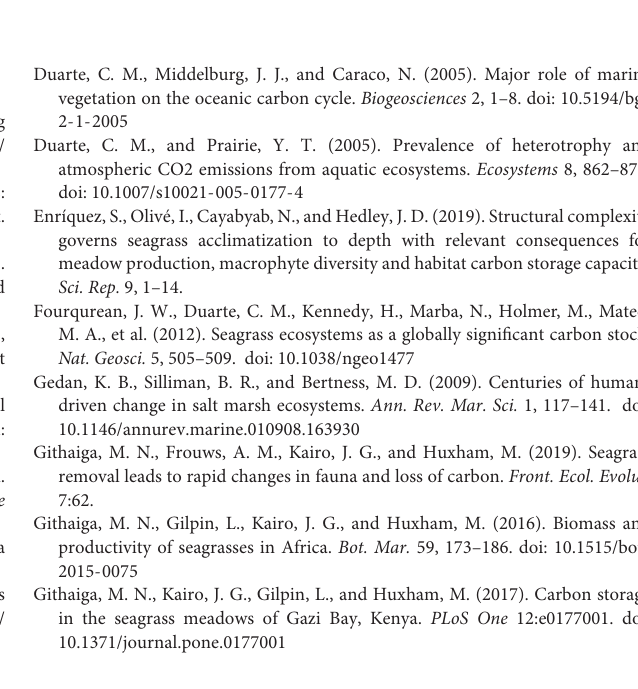
FIGURE S1 | A section of seagrass meadows in Mangrove fringed Eastern creek. FIGURE S2 | A section of seagrass meadows in the Western creek. FIGURE S3 | Residuals of best fitted model (AIC = 22) for the Eastern Creek. FIGURE S4 | Residuals of best fitted model (AIC = 336) for variables the Western